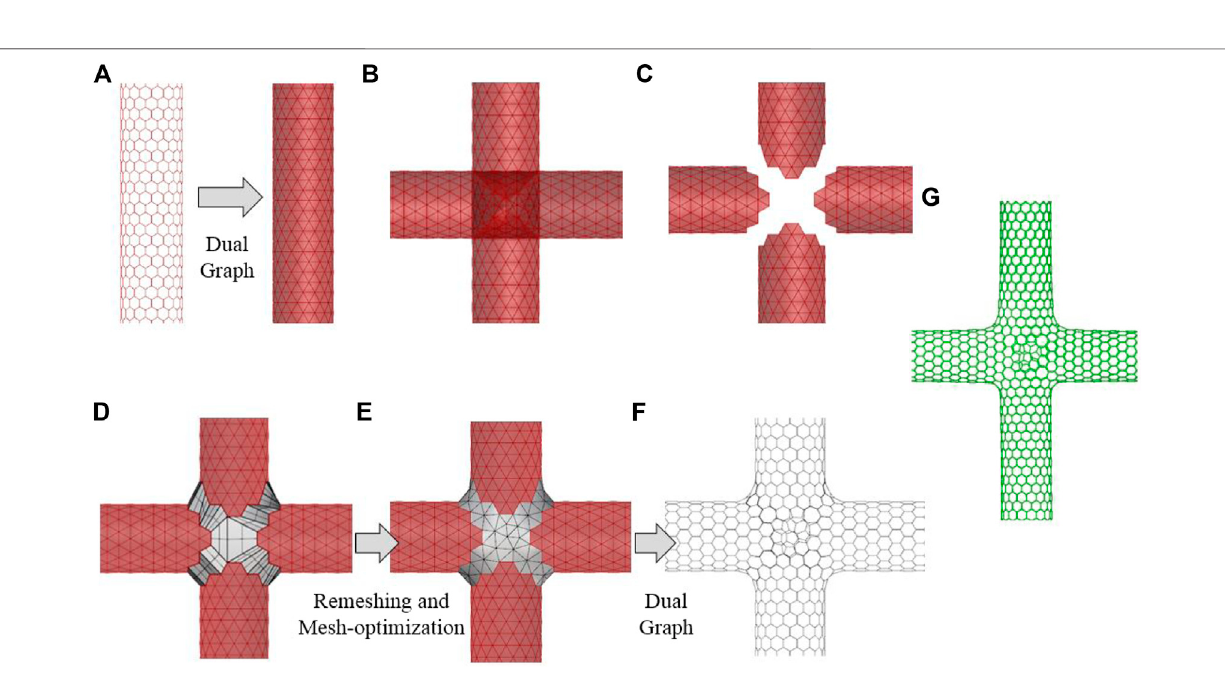
Frontiers in Materials |